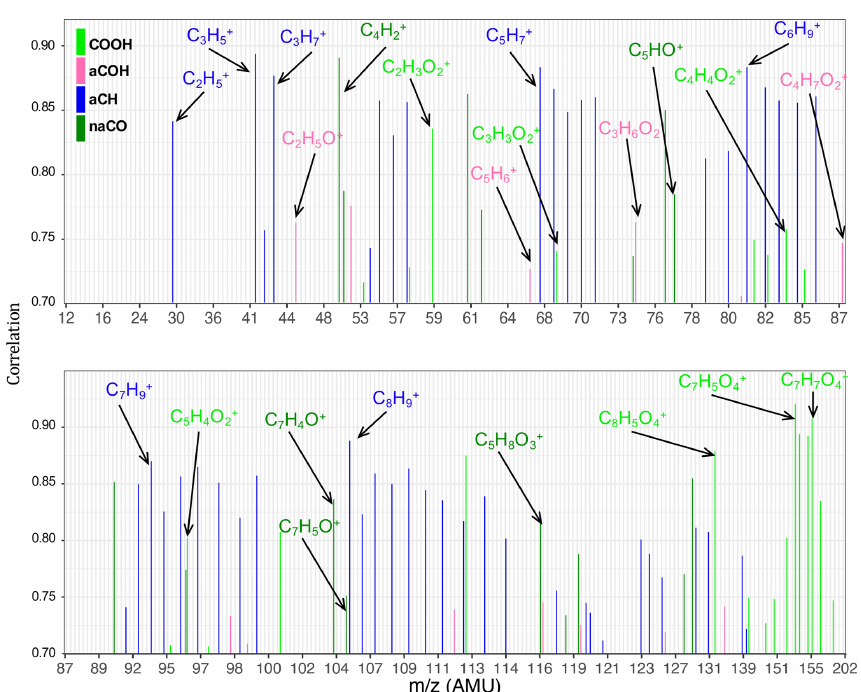
Figure 6. Bar plots showing the Pearson correlation coefficients of normalized individual fragment ion concentrations and normalized functional group abundances. Only values > 0 . 7 are